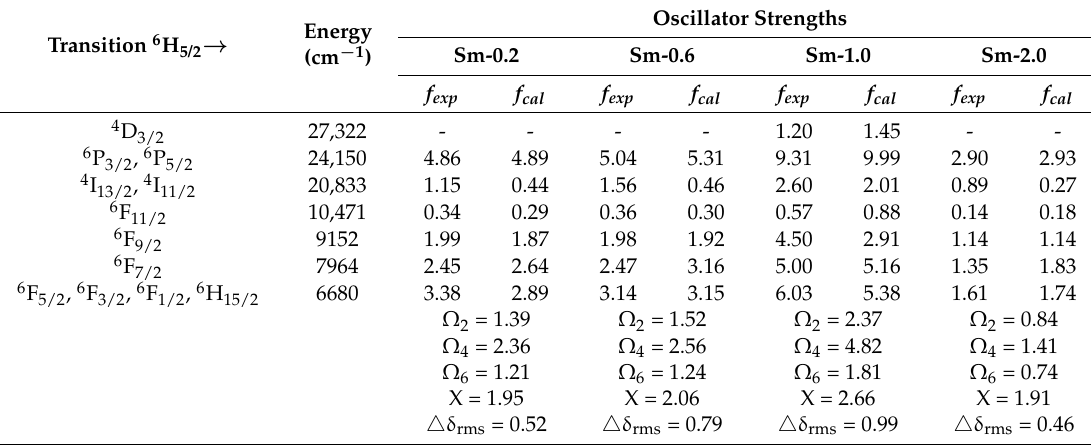
Table 2. Experimental and calculated oscillator strengths (10 − 6 ) for Sm:LN and the Judd–Ofelt intensity parameters Ω λ (10 − 20 ), the root mean square deviation (cid:52) δ rms , and the spectroscopic quality factor X ( Ω 4 / Ω 6 ).